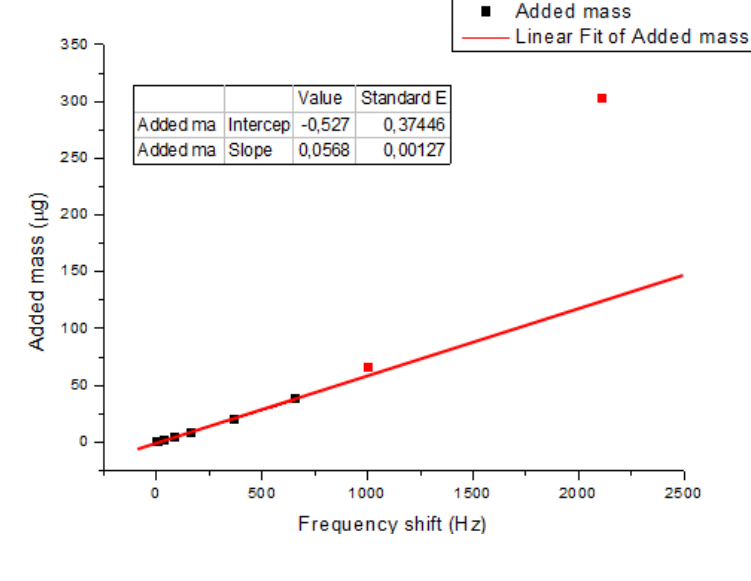
Figure 7. Results of the frequency shift produced by the added mass from the finite element